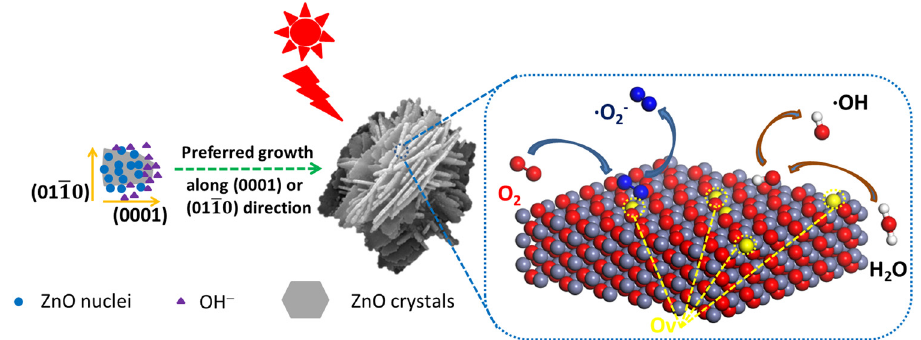
Figure 1: Schematic diagram of growth and photocatalysis of fl ower - like